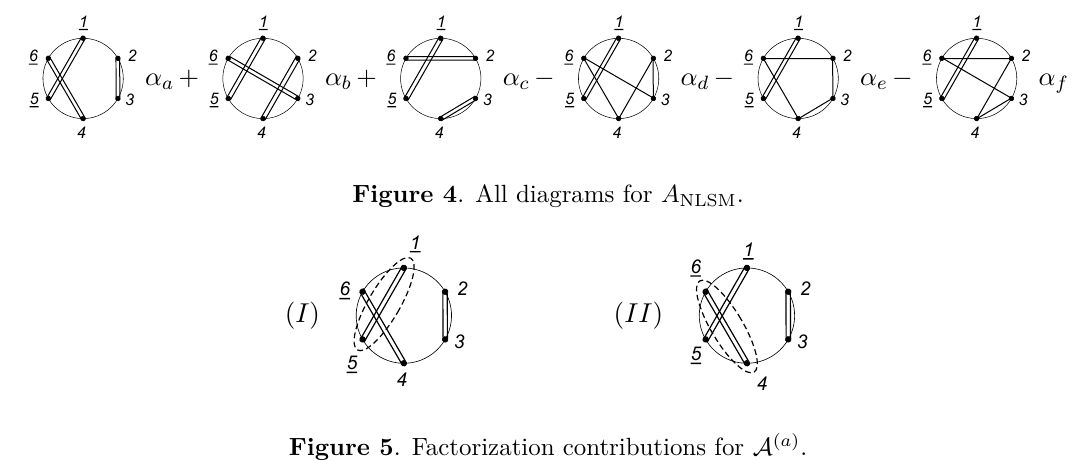
Figure 5 . Factorization contributions for A ( a )